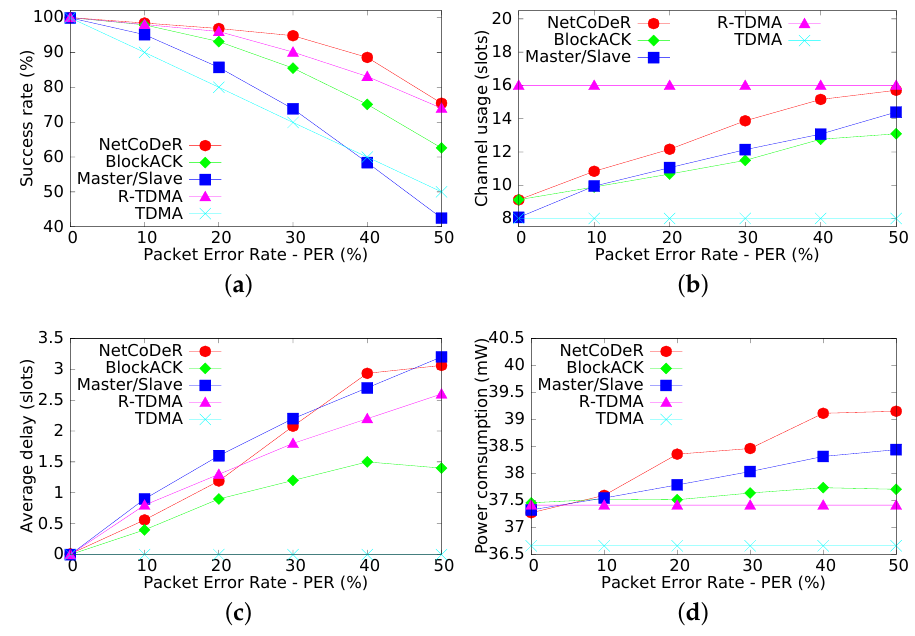
Figure 7. Experimental evaluation. ( a ) Success rate (received/sent data); ( b ) Wireless media utilization; ( c ) Average delay of successfully delivered messages; ( d ) Power consumption of